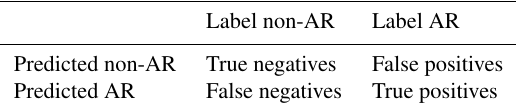
Table 2. A confusion matrix (error matrix) is a way to present the performance of the method (typically, testing accuracy). The matrix reports the number of (i) false positives – cases when the model indicates that an AR exists, when it does not in the ground truth; (ii) false negatives – cases when the model indicates that an AR does not exist, while in fact it does in the ground truth; (iii) true positives – cases when the model indicates that an AR exists, when it does in the ground truth; (iv) true negatives – cases when the model indicates that an AR does not exist, when it does not in the ground